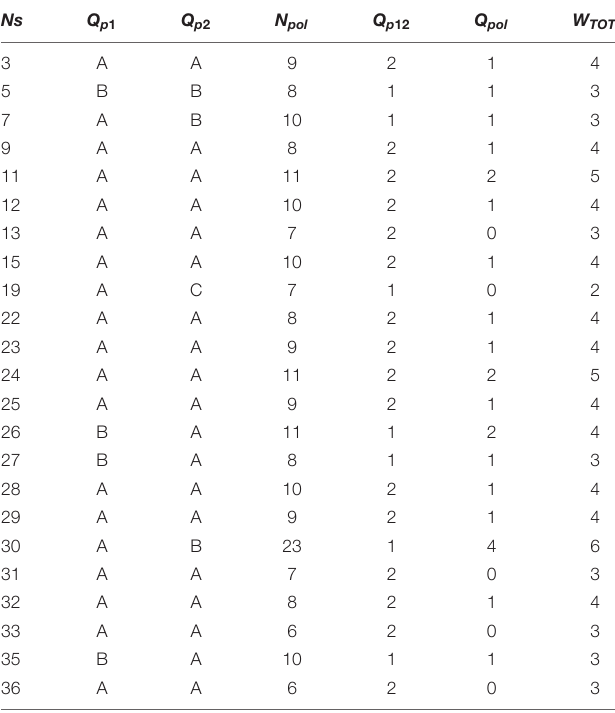
TABLE 2 | Quality classes and assigned weight for the focal mechanisms used in the FMSI